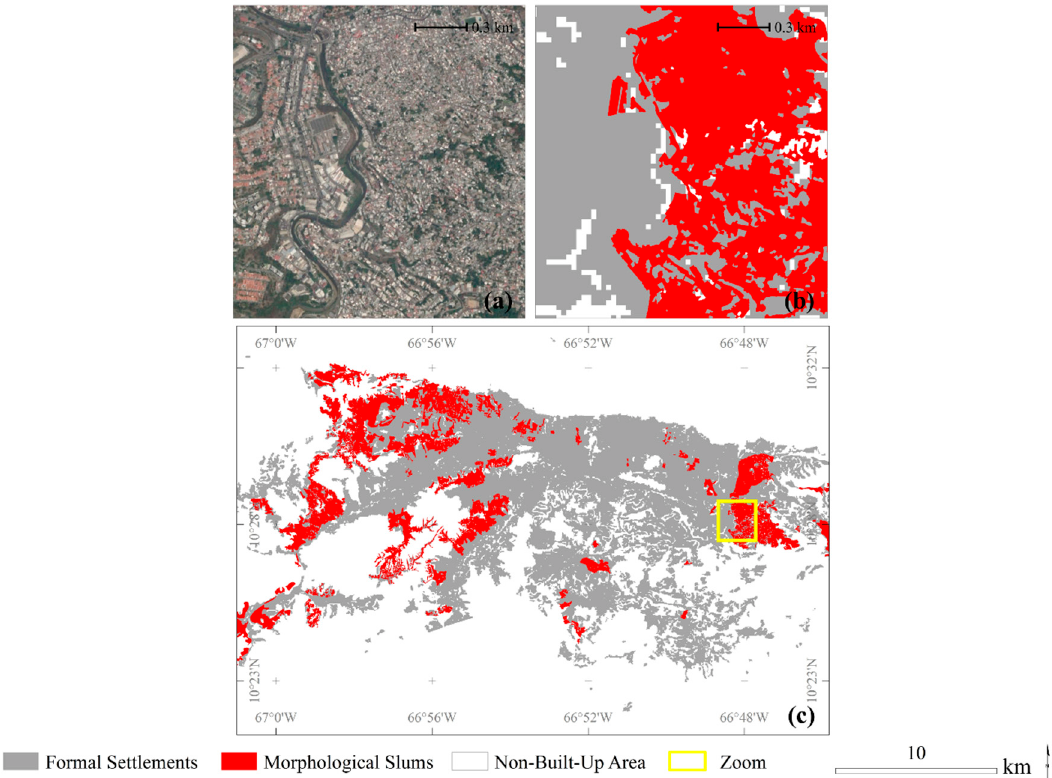
Figure 4. ( a ) Classification of morphological settlement types in Caracas based on VHR images (WorldView-3) resulting in ( b , c ) either formal settlements or morphological slums. Table 3. Root Mean Squared Error (RMSE) of filtered ASTER